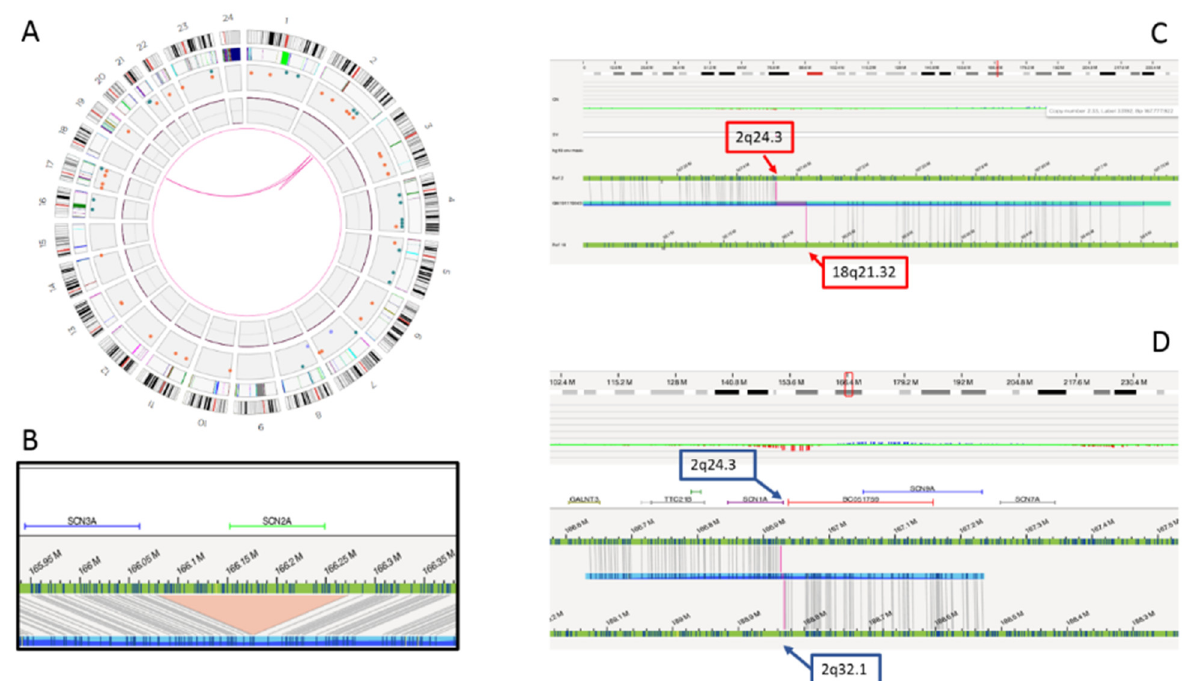
Figure 3. Complex genomic rearrangements (CGR) disclosed by optical genome mapping. Graphic visualizations of the rearrangement include the circle plot ( A ), the SCN2A gene deletion ( B ), the 2;18 translocation with breakpoints at 2q24.3 and 18q21.32 ( C ) and paracentric inversion involving 2q24.3 and 2q32.1 breakpoints ( D ).